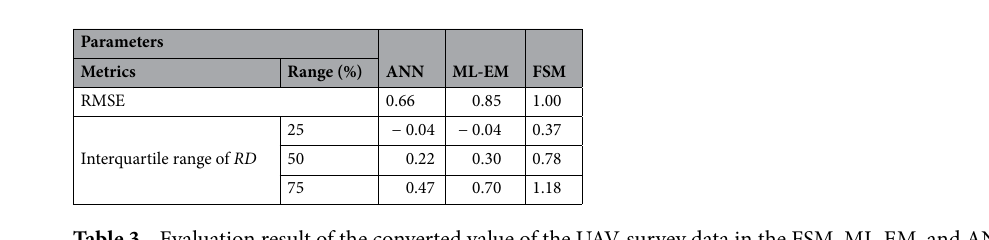
Table 3. Evaluation result of the converted value of the UAV-survey data in the FSM, ML-EM, and ANN. All data numbers are 3442.